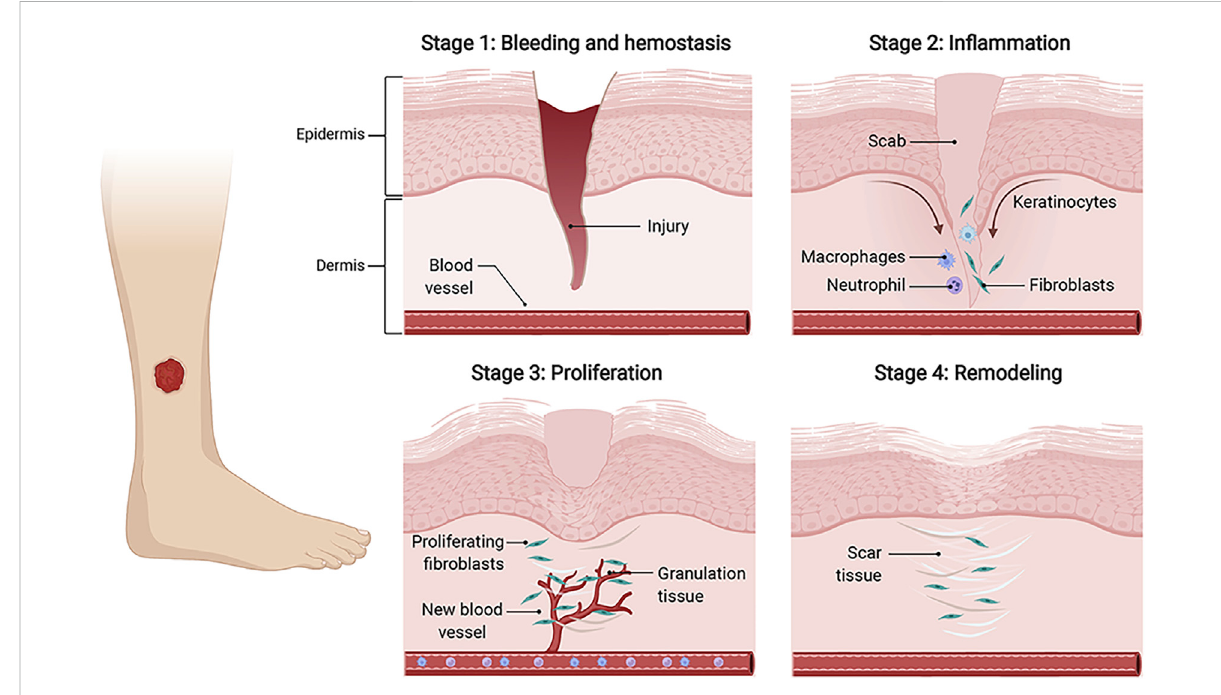
FIGURE 1 The wound healing process. The four temporally overlapping stages of wound healing mainly include hemostasis, in fl ammation, proliferation, and tissue remodeling, which involves multiple cells, such as fi broblasts, keratinocytes (KCs), endothelial cells (ECs), and immune cells. Initially, fi brinogens and platelets combine to form the thrombus to stop bleeding, and provide fi brin matrix for in fi ltrating cells. In the in fl ammation stage, immune cells, represented by neutrophils and macrophages, are recruited to clear invading pathogens and debris. During the proliferative phase, activated fi broblasts synthesize new ECM and form granulation tissue. KCs migrate to close the wound gap, and ECs migrate to build new blood vessels. Finally, new blood vessels regress, and granulation tissues are remodeled into scar tissues. keratinocytes (KCs), endothelial cells